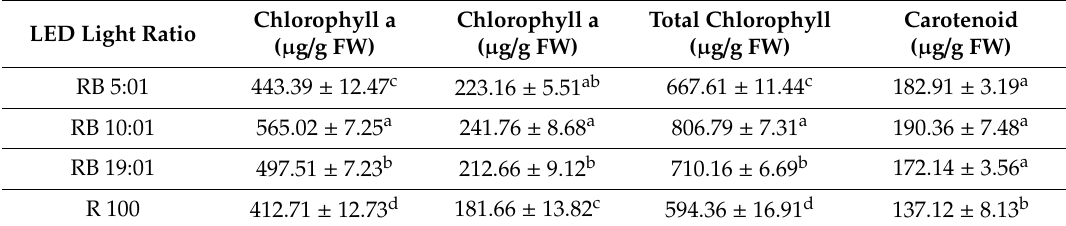
Table 2. Effects of various RB light ratios on the pigment contents of tomato plantlets. Table 2. E ff ects of various RB light ratios on the pigment contents of tomato plantlets. LED Light Ratio LED Light Ratio